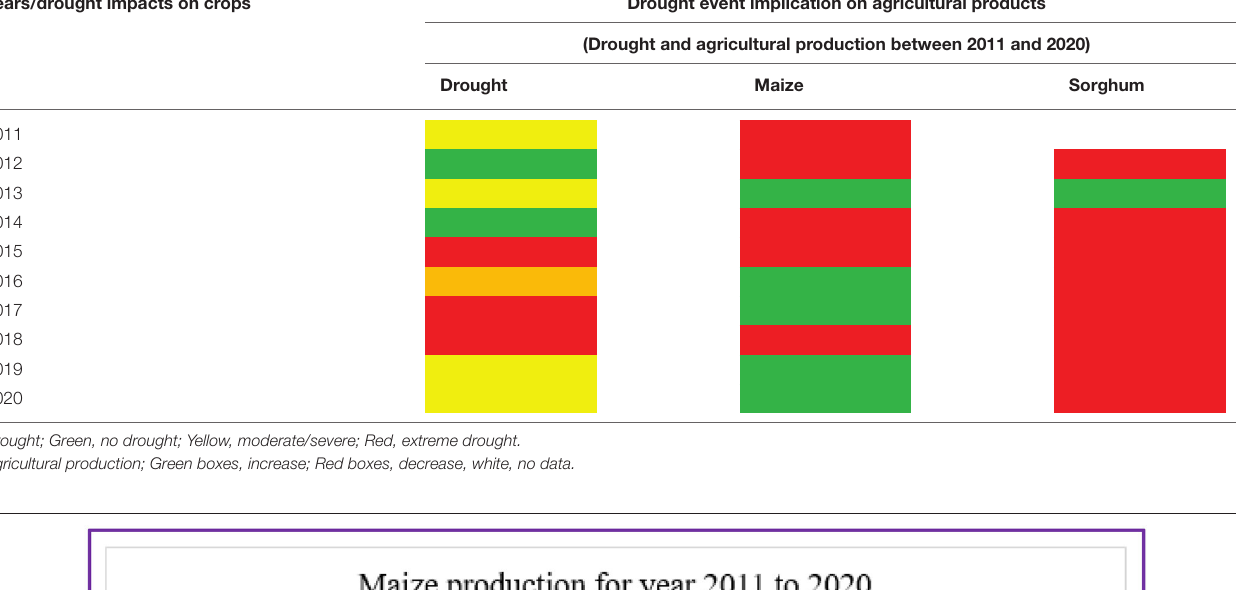
TABLE 1 | Potential drought impacts on agricultural products between 2011 and 2020. Years/drought impacts on crops Drought event implication on agricultural products (Drought and agricultural production between 2011 and 2020) Drought Maize